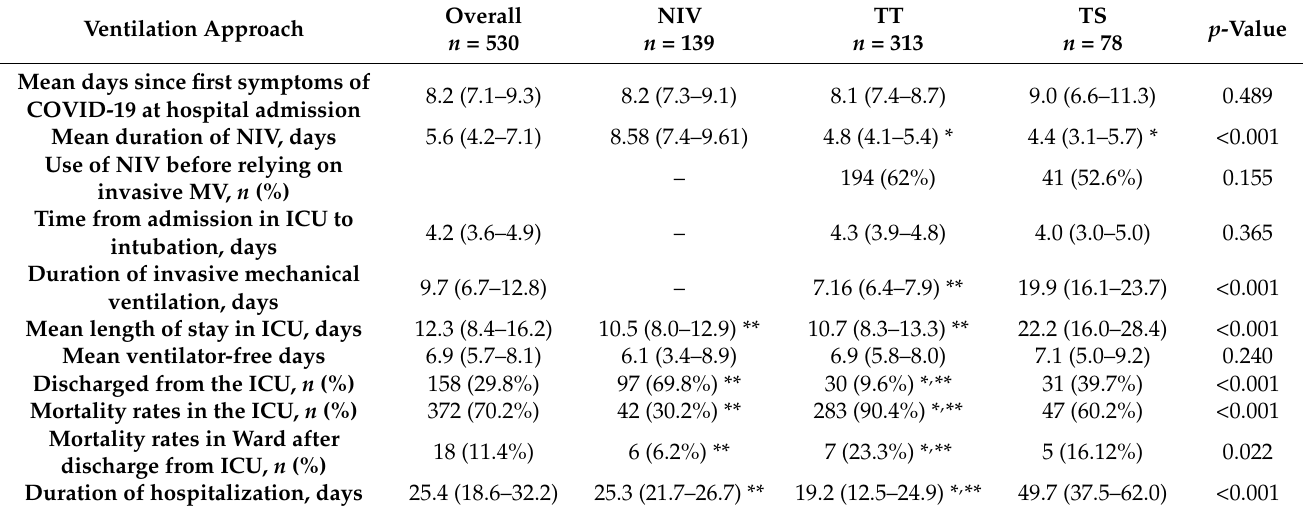
Table 2. Impact of airway and ventilation approach on survival rates in terms of successful discharge from ICU. Data are presented as mean and 95% confidence intervals, median interquartile ranges, or numbers and percentages as appropriate. Abbreviations: NIV (non-invasive ventilation); TT (invasive mechanical ventilation with tracheal tube); TS (invasive mechanical ventilation with tracheostomy); ICU (intensive care